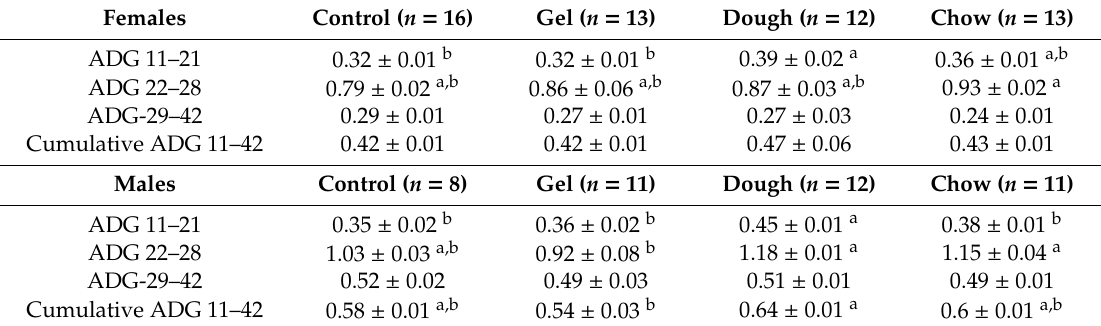
Table 3. Average daily gain (ADG) with dietary supplementation by growth phase in males and females.